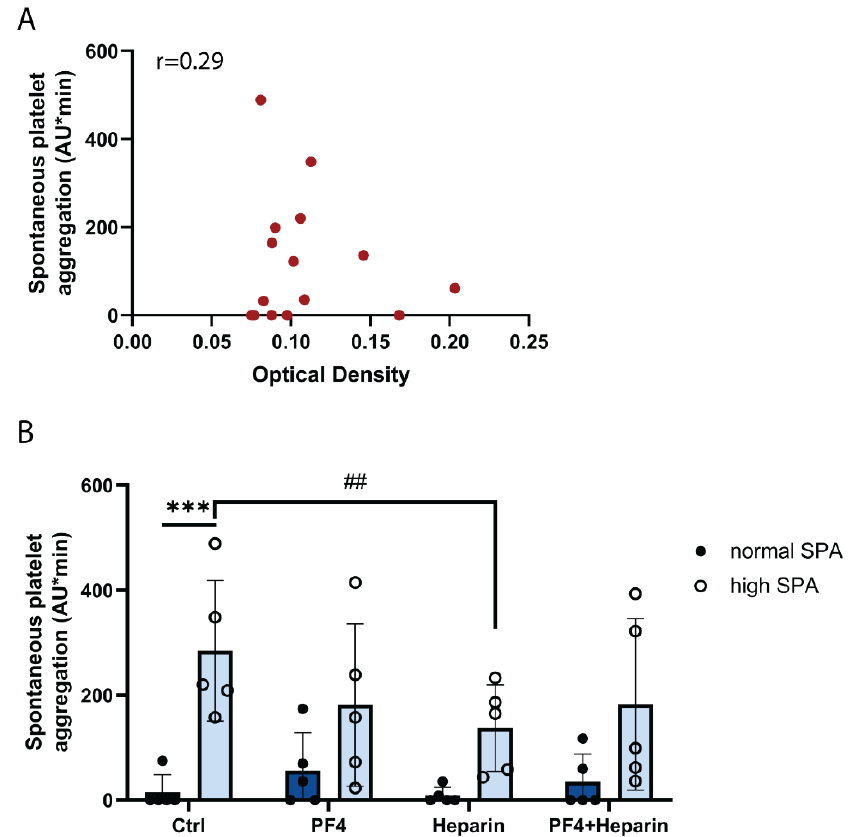
Figure 4. SPA is not mediated by anti-PF4 IgG and not stimulated by PF4 and/or heparin. ( A ) No correlation between SPA and serum titers of anti-PF4/polyanion IgG. The scatterplots display SPA and optical density of the IgG titers. Each dot on the graph represents a subject ( n = 17). ( B ) SPA was not increased by incubation with PF4 and/or heparin. The hirudin-anticoagulated blood samples were prewarmed for 3 min at 37 ◦ C. PF4 (5 µ g/mL) or heparin (1 U/mL) were added, stirring was started and aggregation was measured for 10 min. The values are means ± SD ( n = 5). *** p < 0.001, ## < 0.01.